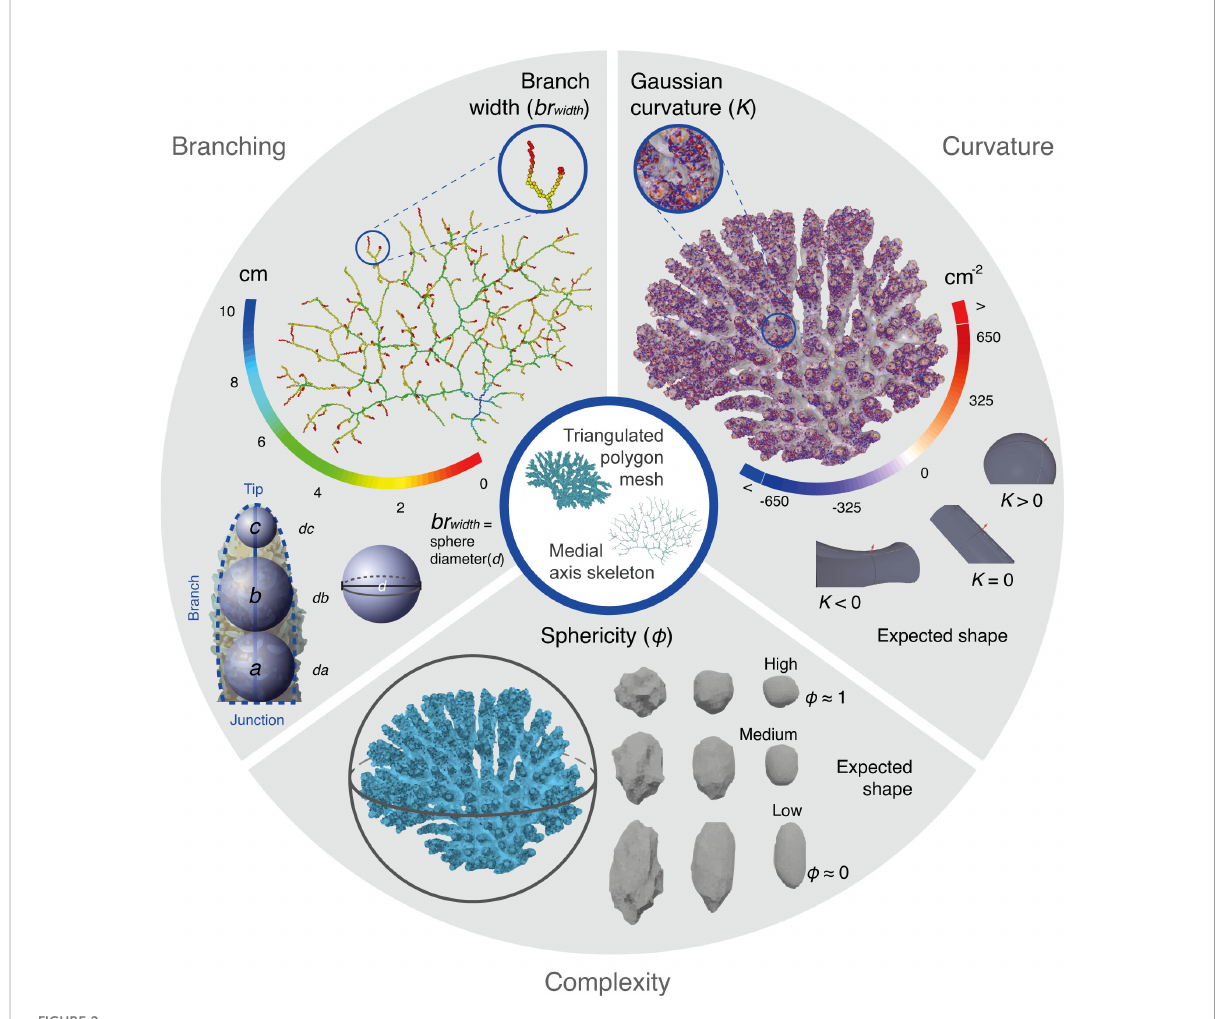
FIGURE 2 Types of morphological variables assessed from the 3D coral models and representative measurements. Branching estimations (upper left) such as the width ( br width ) at different points between the tip and the branch junction were performed using the diameter of spheres ( d ) between the medial skeleton axis (solid blue line) and the smoothed polygon mesh (dashed blue line). Measures of the surface curvature (upper right) such as the Gaussian estimations ( K ) were obtained from the polygon meshes (see expected shapes according to values and Supplementary Figure S3). Complexity shape measures (bottom) were estimated as global values for each coral fragment, like sphericity ( j ), which captures the volume compactness by measuring how close is the shape of each coral fragment to a sphere (see expected shapes according to